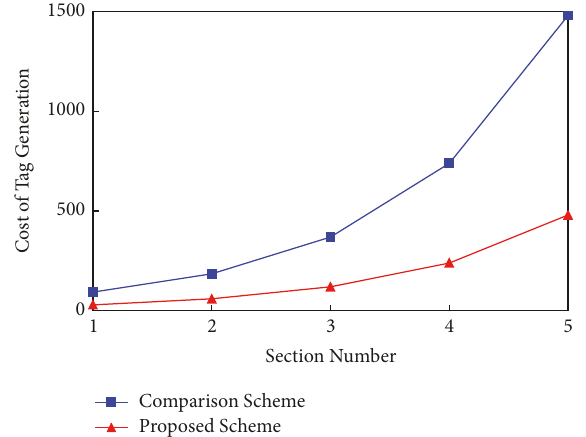
Figure 6: Computation cost of